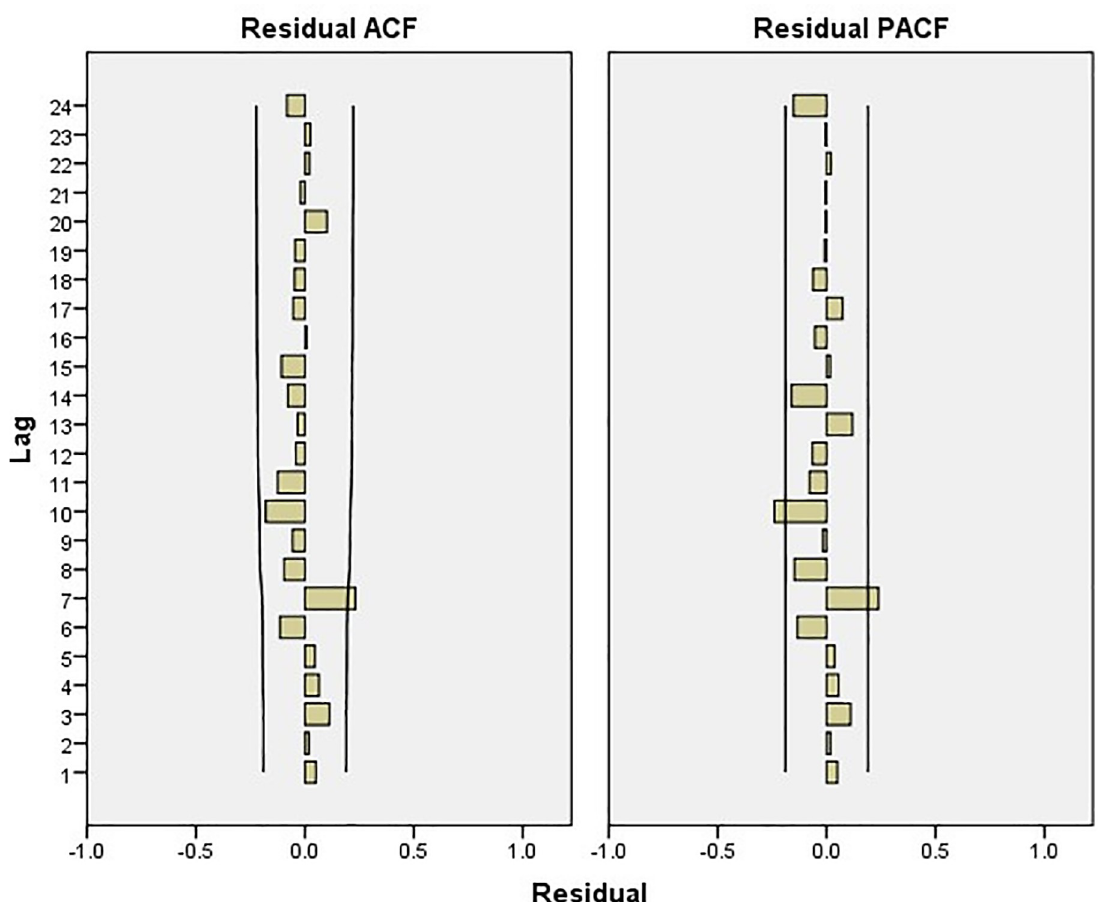
Fig 7. Stationarity analysis using first-order difference for the HFRS incidence data. The ACF and PACF values for HFRS incidence after seasonal difference adjustment for each lag.